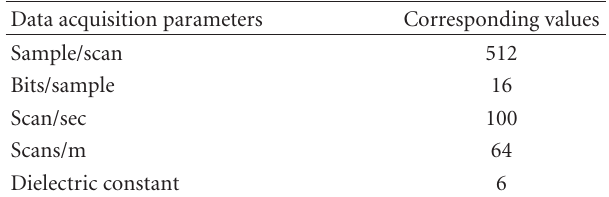
Table 1: Acquisition parameters used for collection of 2D and 3D profiles across HF2 scarp at Sandhwal village.